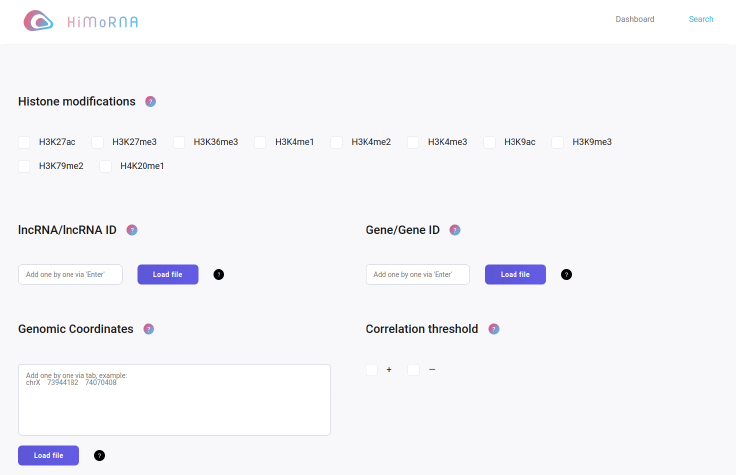
Figure 1. HiMoRNA web-interface. Users can query the resource through selecting lncRNA, gene, genomic regions and setting a threshold for the sign and an absolute value of an